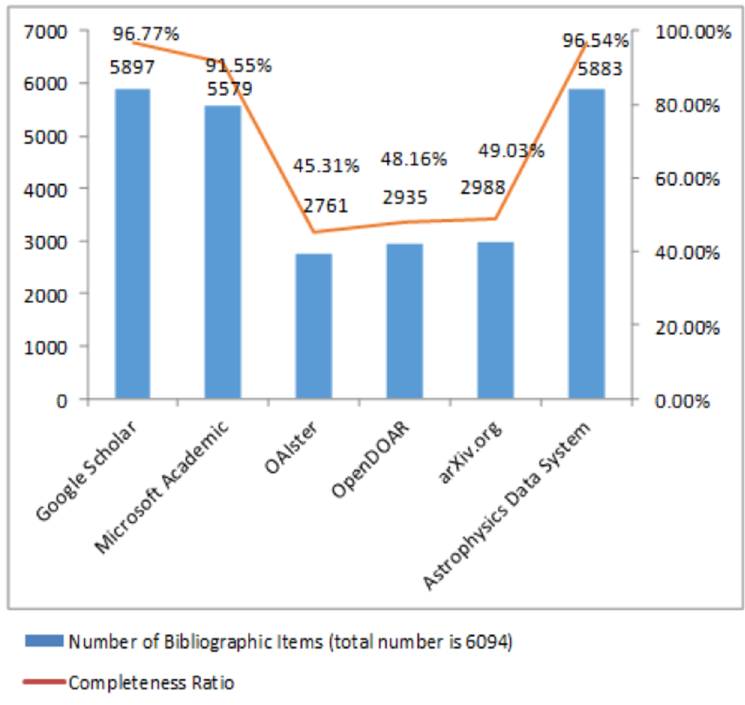
Fig 1. Completeness of the sample publication list in physics in the open